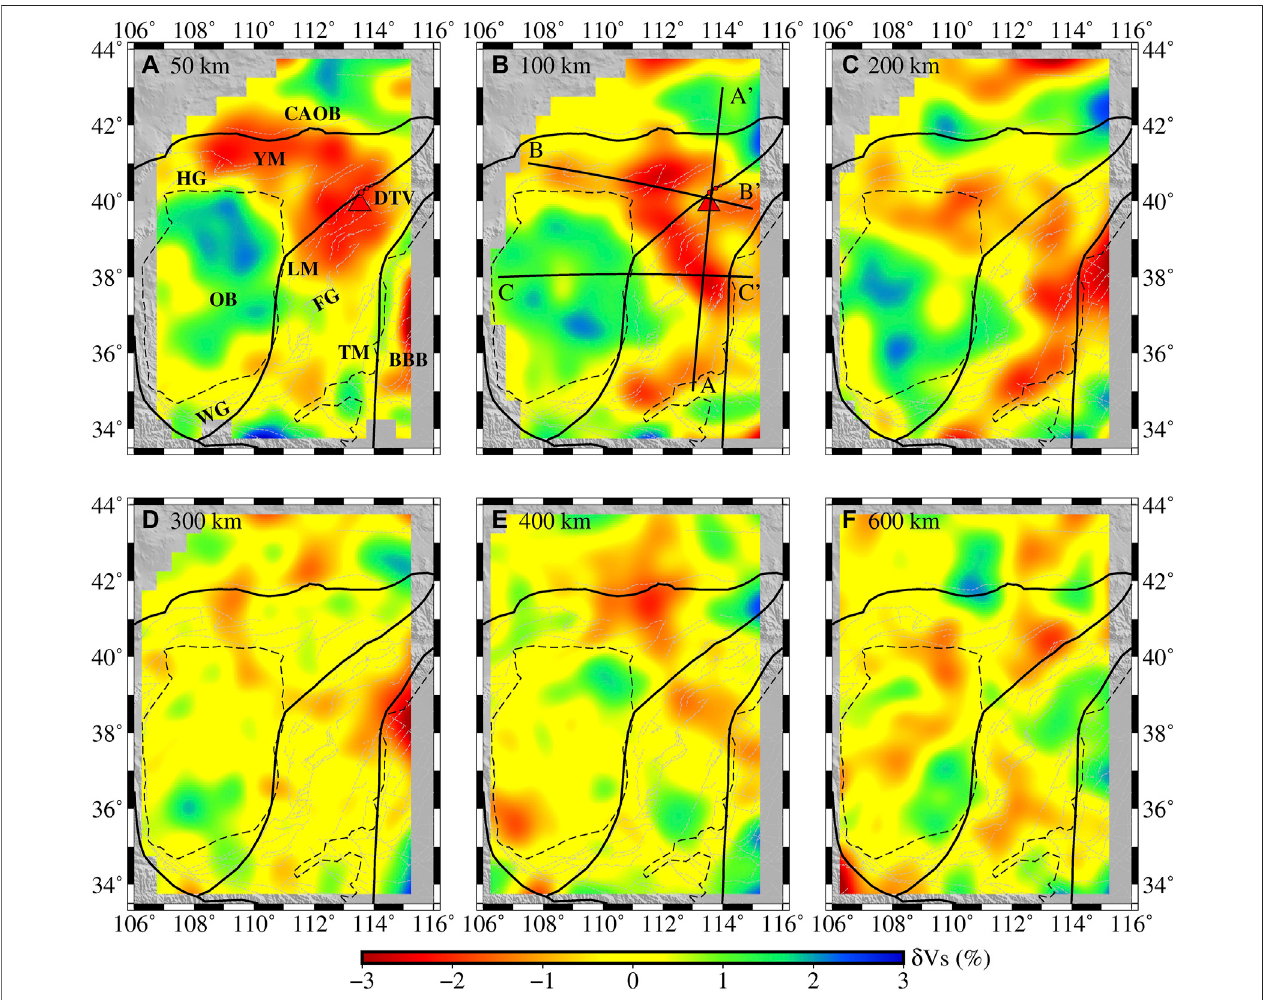
FIGURE4| Horizontalslices (A – F) ofSwavevelocityfromtheseismictomographicinversion.Thedepthofeachlayerisshownintopleftcornerofeach fi gure.The abbreviations are the same as those de fi ned in the caption of Figure 1 . The black lines labeled AA ′ , BB ′ and CC ′ in fi gure (B) represent the locations of the vertical sections shown in Figure 5